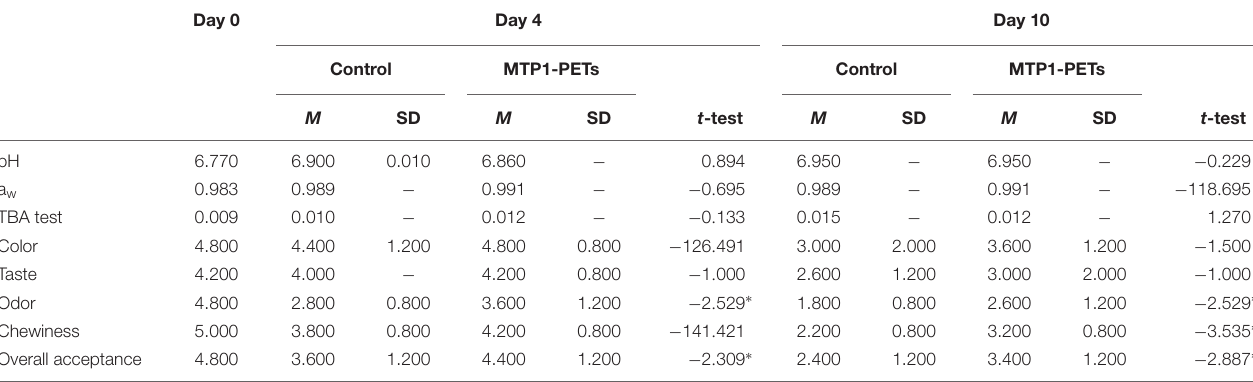
TABLE 2 | Effects of MTP1-PETs on physical–chemical (pH, a w , and TBA test) and sensory evaluation of buffalo ricotta cheese